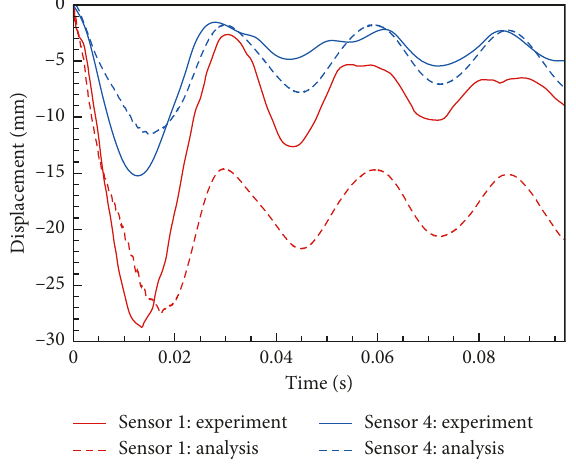
Figure 9: Displacement at sensors 1 and 4.